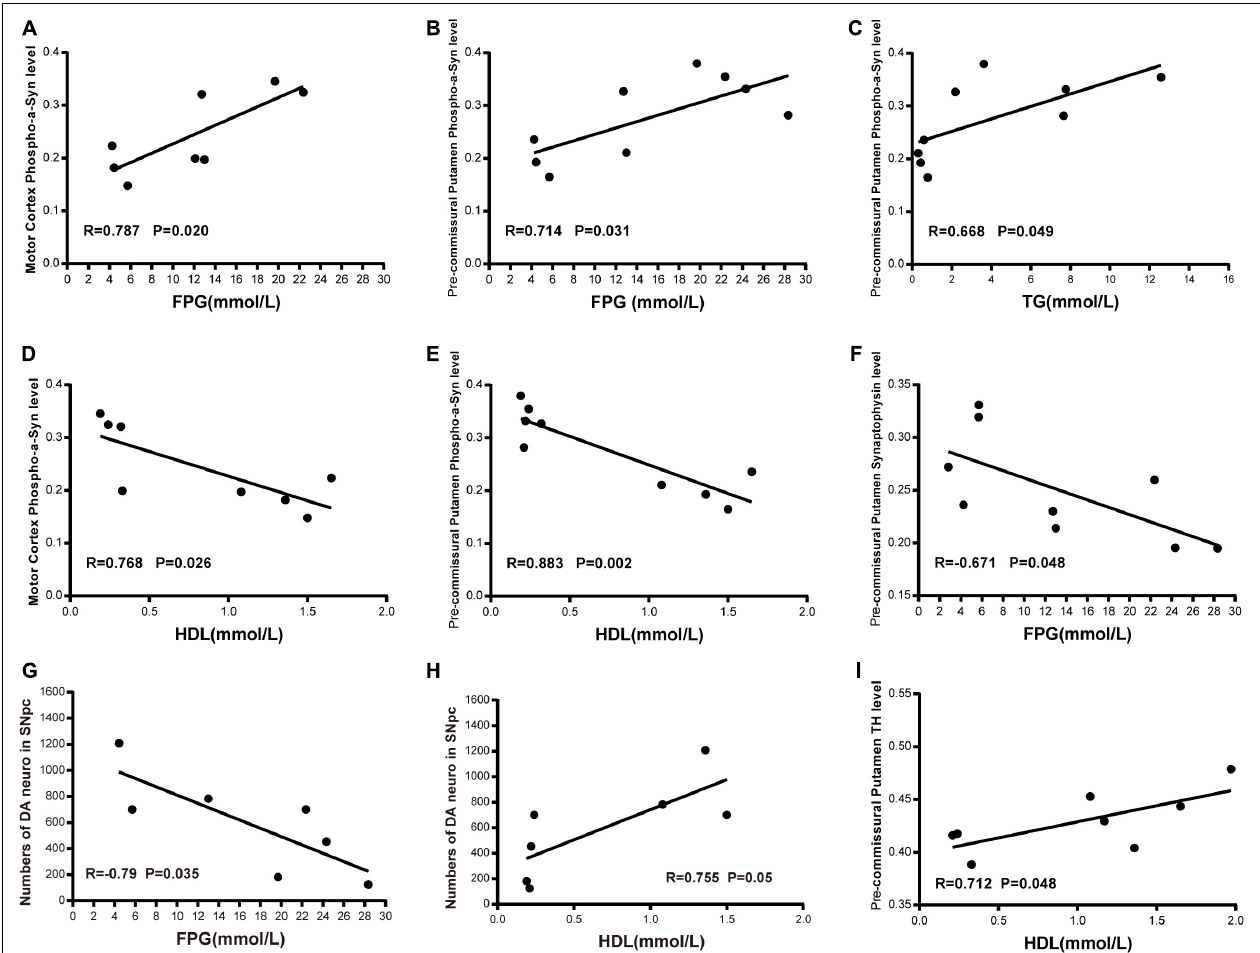
FIGURE 10 | Correlation between biochemical indicators and phosphorylated- α -synuclein; synapse density in the motor cortex and the pre-commissural putamen; dopaminergic neurons and terminals in the substantia nigra and the pre-commissural putamen. Scatter diagram of Pearson correlation test between α -synuclein level or dopaminergic system and FPG level (A,B,F,G) , TG level (C) , HDL level (D,E,H,I)